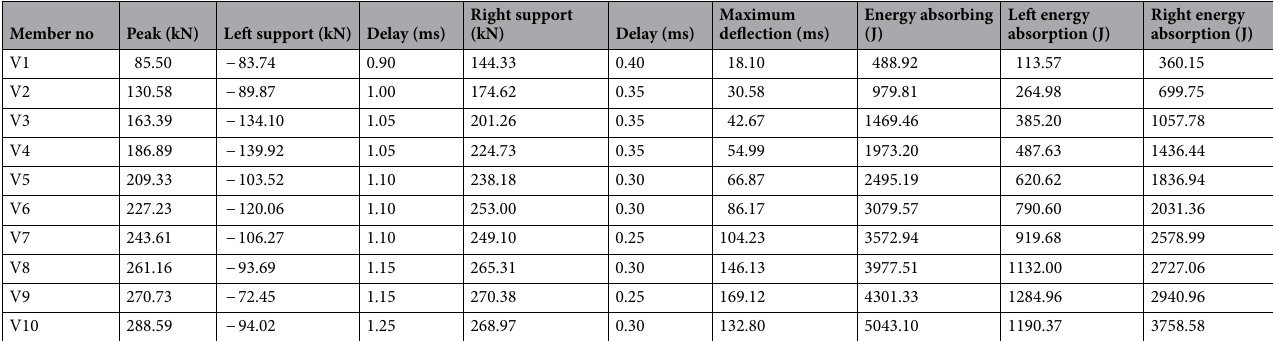
Table 8. Data analysis of relevant member’s results at various impact velocities. The impact force is positive downward, while the reaction force is upward.